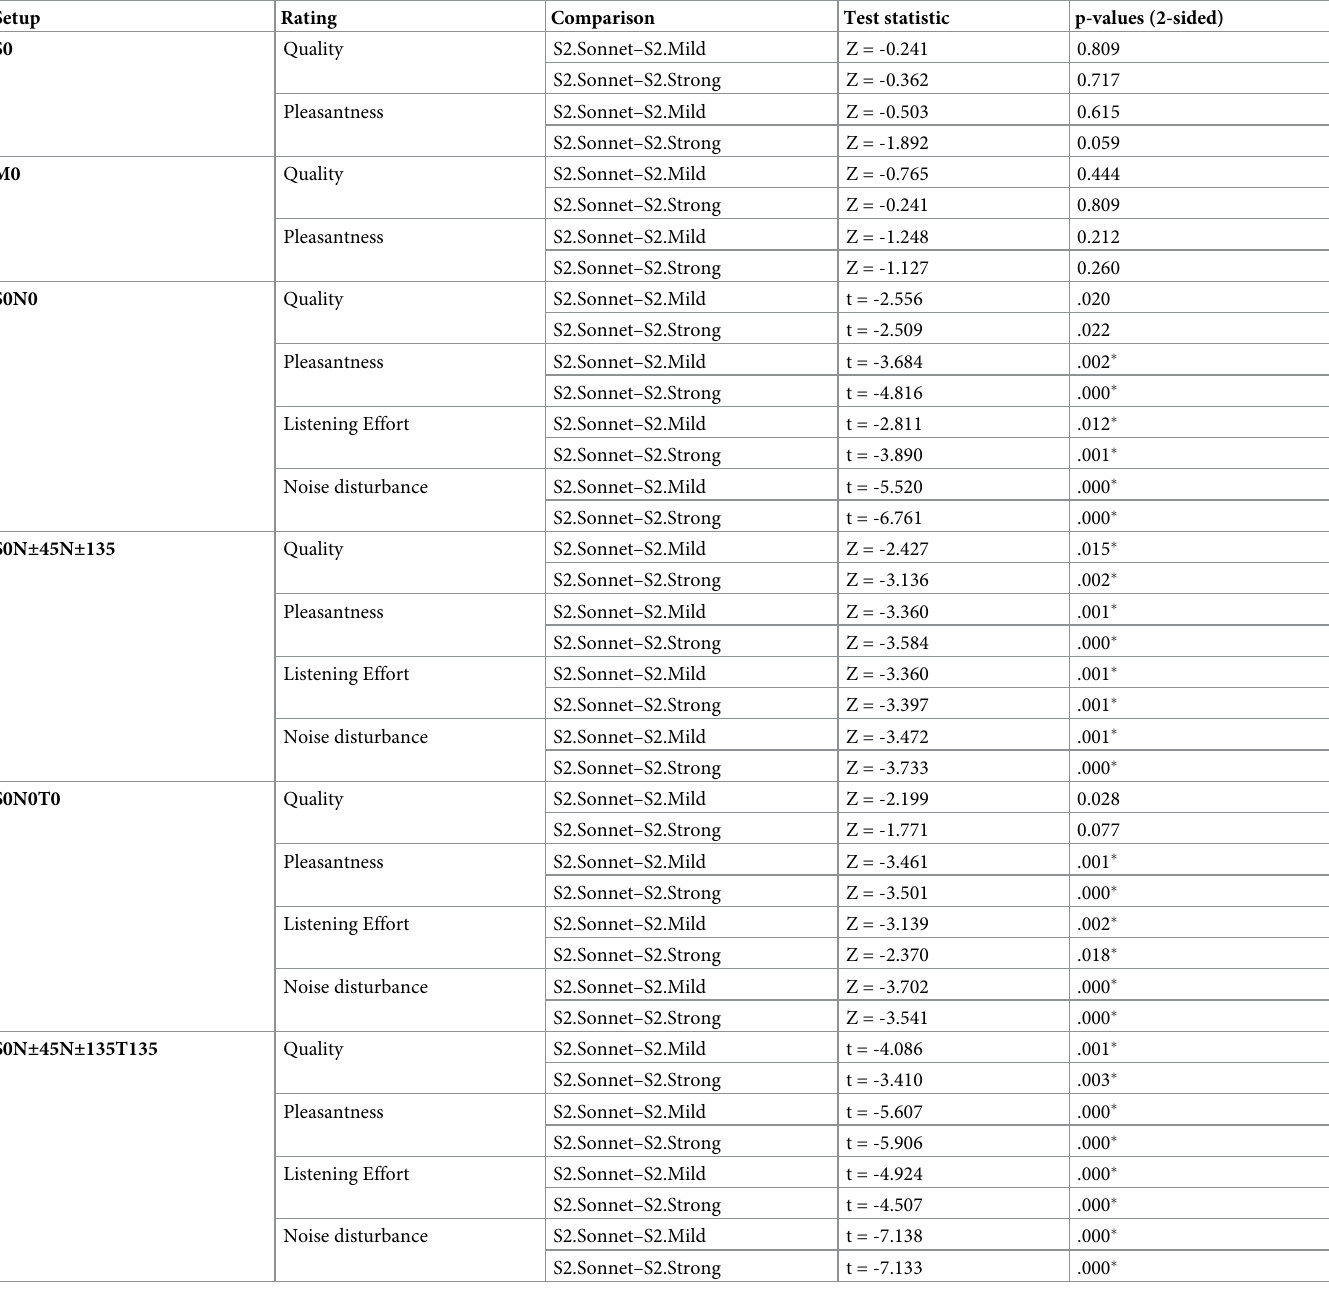
Table 7. Paired comparisons for subjects’ quality ratings between the SONNET and the SONNET 2 configurations S2.Mild or S2.Strong (original p-values).